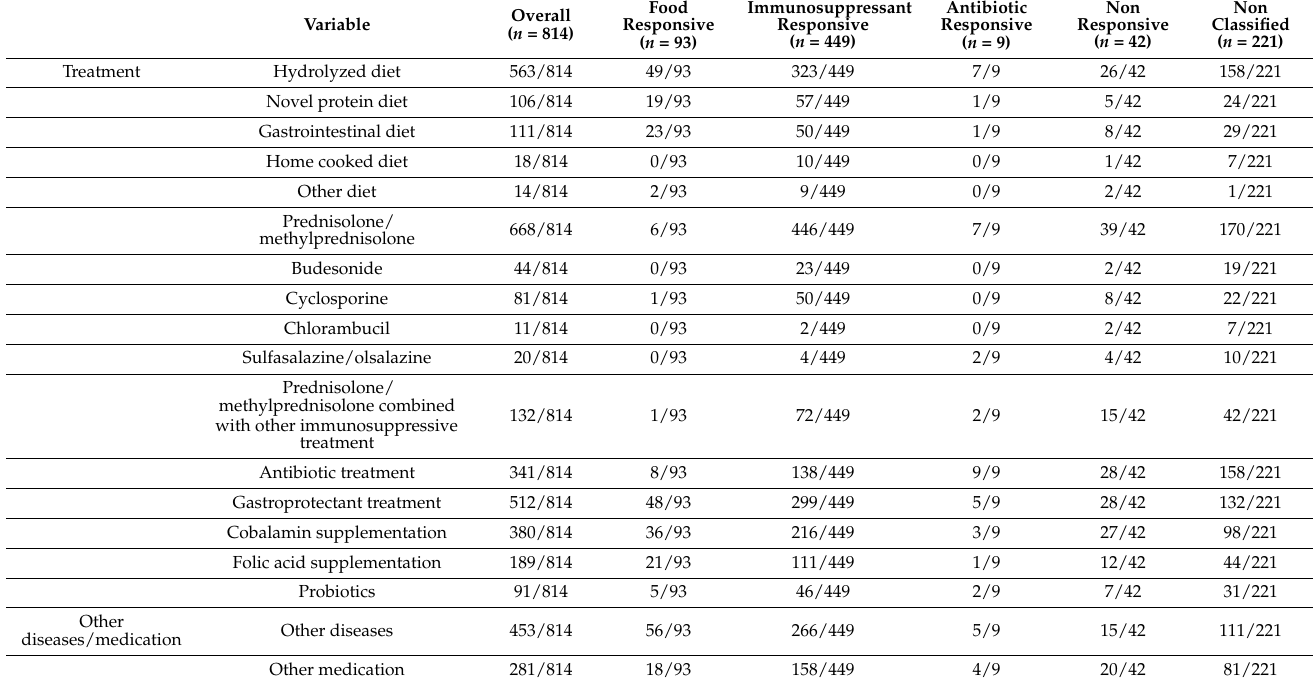
Table 4. Summary of treatments used for the dogs in the study population as well as information concerning co-morbidities by treatment outcome group. Other immunosuppressive treatment include cyclosporine, azathioprine, chlorambucil, budesonide, and sulfasalazine/olsalazine. Gastroprotectant treatment included proton pump inhibitors, sucralfate, and/or famotidine. Notice that a dog may have received more than one of the listed medical